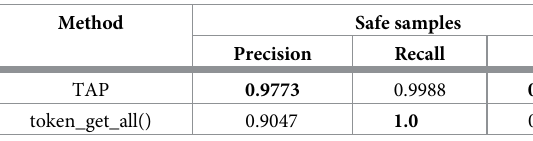
Comparison of multiclass classification models. In order to prove TAP’s ability to mul- ticlass classification problems, we designed experiments on TAP and RIPS. We used RIPS to detect the 10 types of data subsets separately, and then manually counted and analyzed the results. The datasets are extremely imbalanced, the confusion matrix without normalization does not look intuitive and is not easy to evaluate the classification effect, so we use the nor- malized confusion matrix. Table 5. Results comparison with TAP and